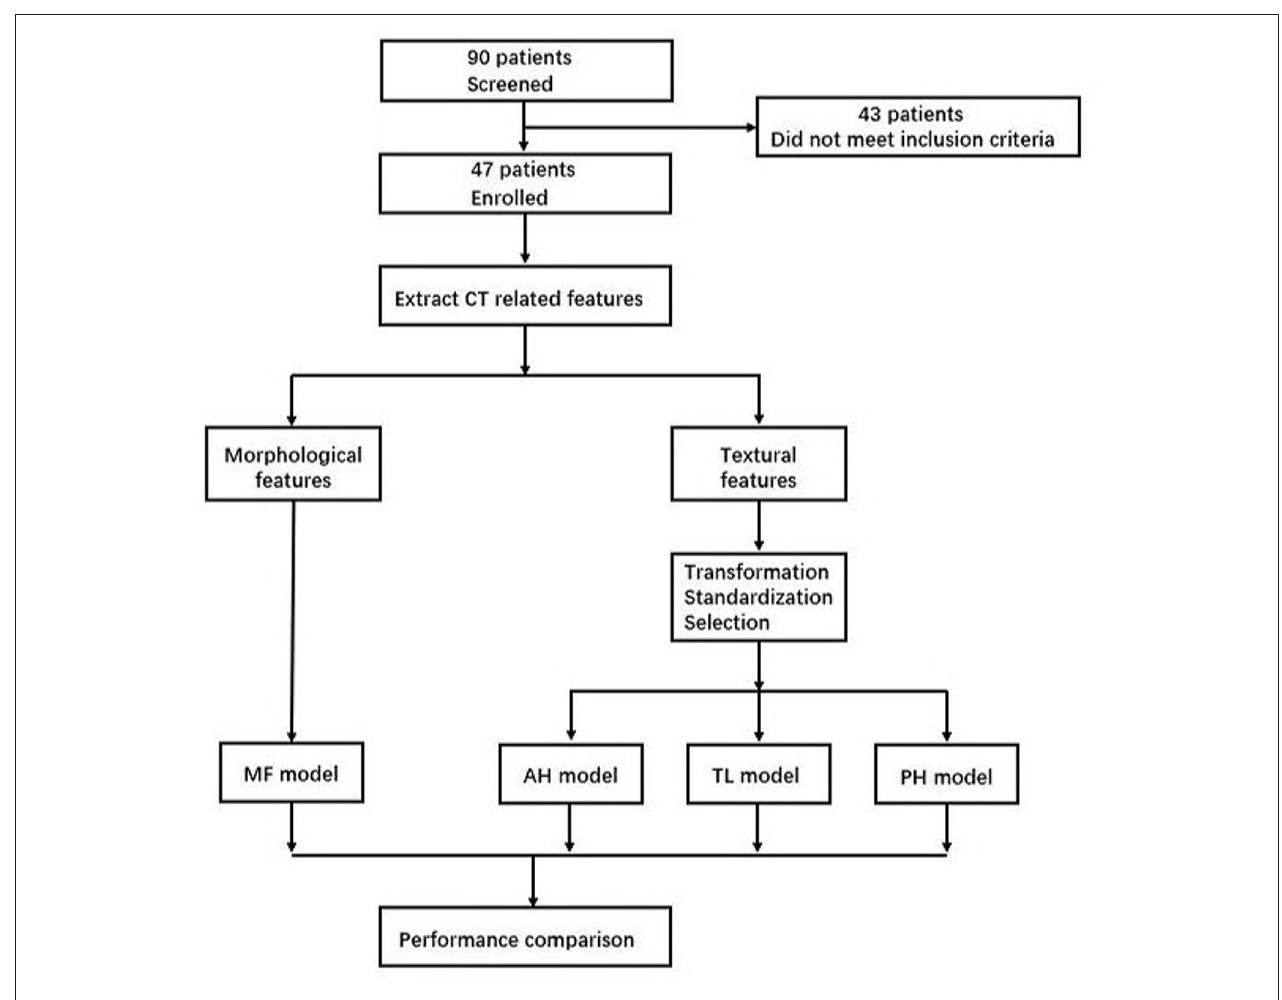
FIGURE 2 | Model establishment and analysis process. MF, morphological features; AH, anterior horn; TL, temporal lobe; PH, posterior horn.